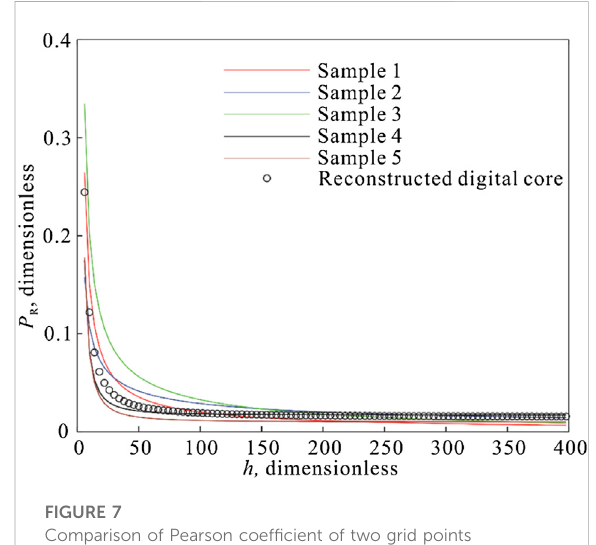
FIGURE 7 Comparison of Pearson coef fi cient of two grid points between reconstructed digital cores and core samples.